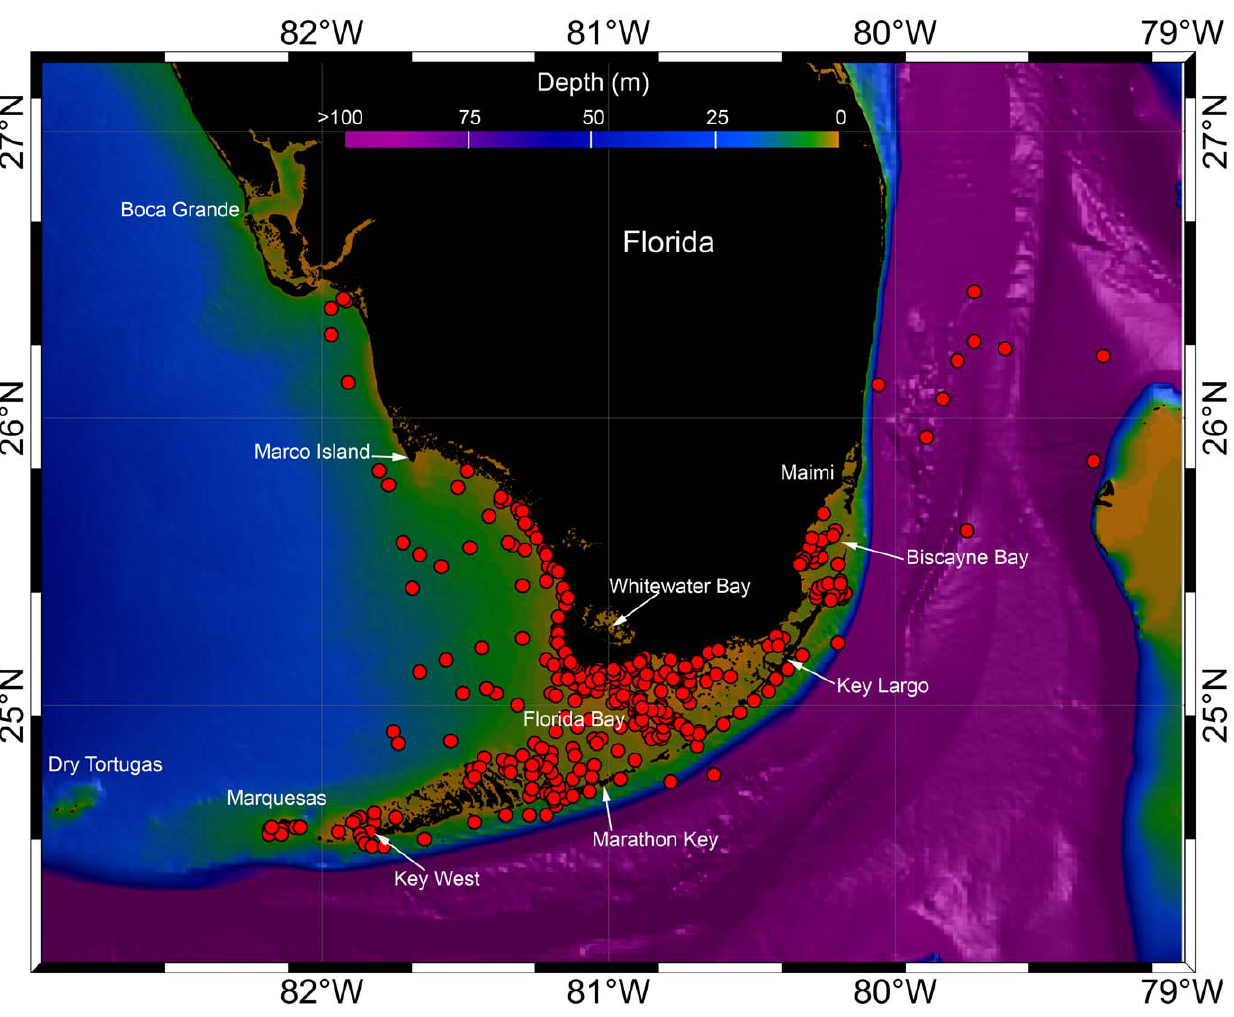
Figure 2. Track positions of 16 bull sharks (red dots) on bathymetry of the study area. All geolocations represent 12 hour interval positions (midnight and noon) filtered using piecewise Be´zier interpolation. Depths are scaled from 0 to 100 m as indicated by the color bar.